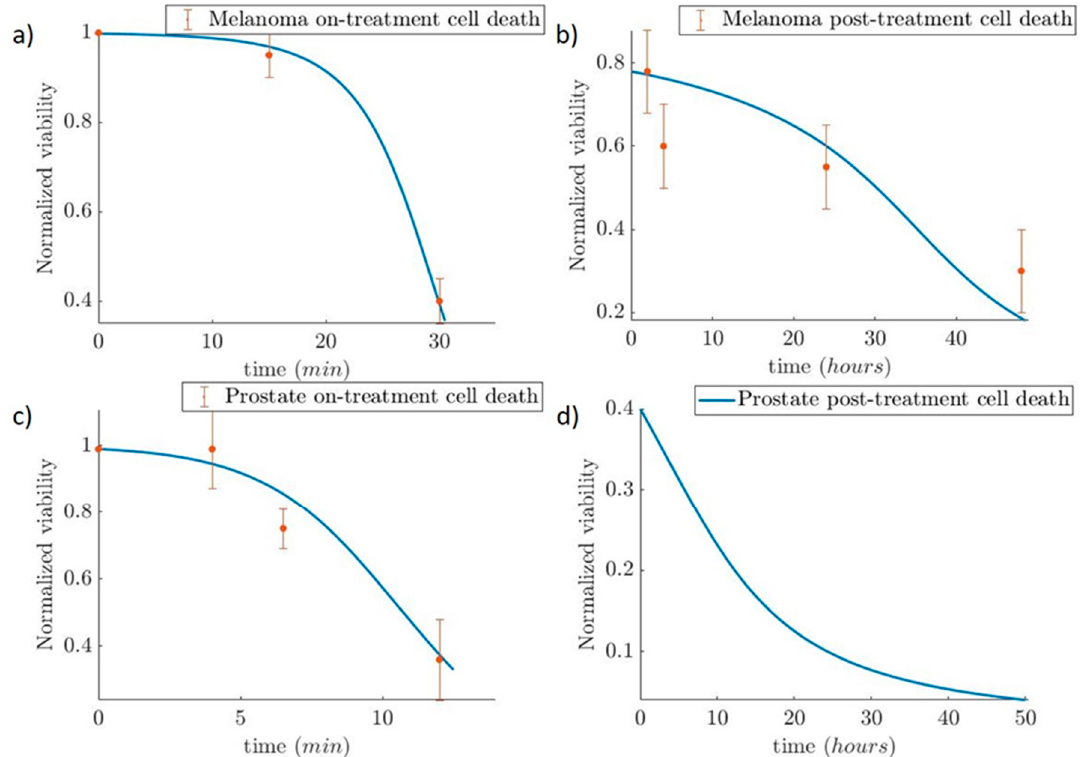
Figure 14. Simulation of tumor response to hyperthermia treatment. ( a , c ) Depiction of the fast cell death that occurs during the treatment for melanoma and the prostate cancer cells. ( b , d ) Depiction of post-treatment slow cell death for melanoma and the prostate cancer cell, respectively. The experimental data have been taken from Blanco-Andujar et al. [39] and Feng et al. [40] for melanoma, and Huang et al. [41] for prostate cancer.